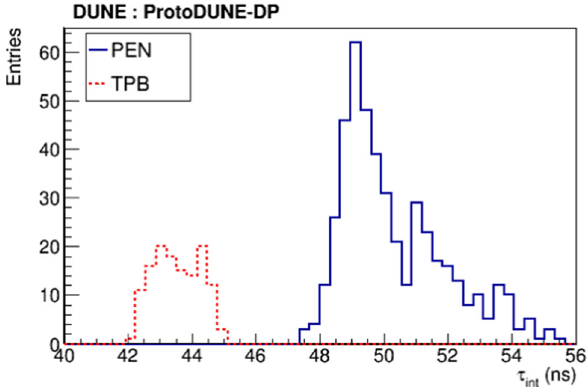
Fig. 12 τ int distribution obtained from the fit to the average waveform for PEN (blue) and TPB PMTs (red)